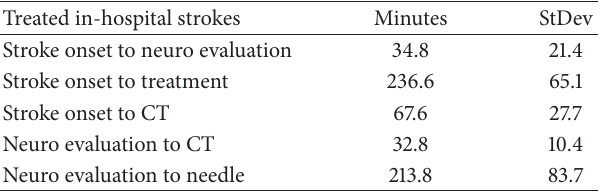
Table 5: In-hospital stroke